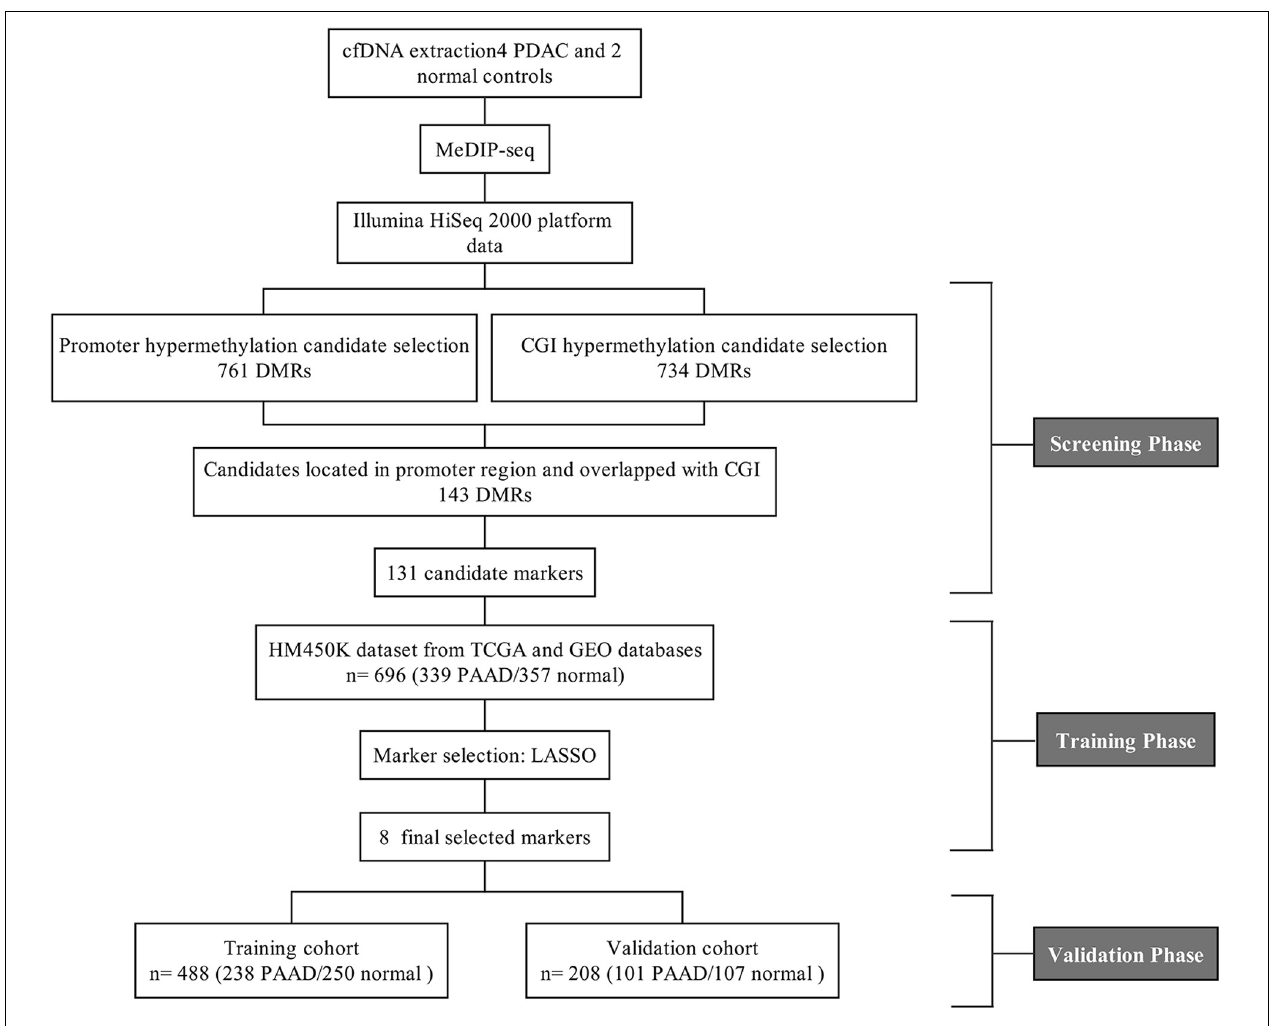
FIGURE 1 | The flow chart of screening cfDNA methylation biomarkers in pancreatic cancer.